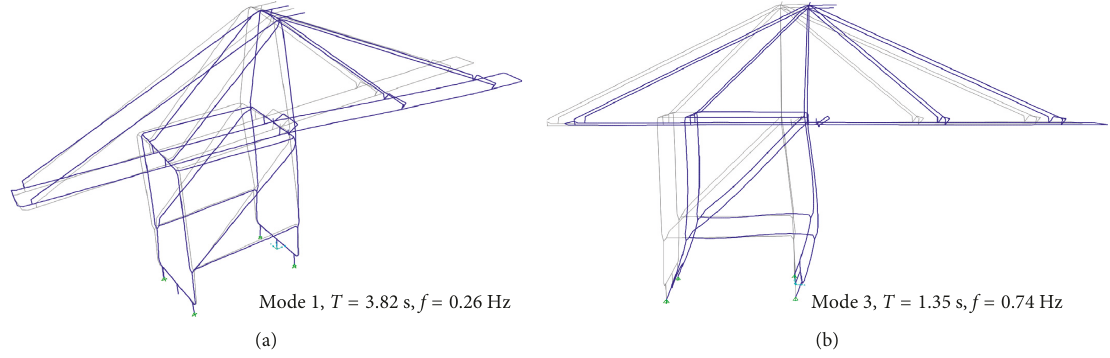
Figure 5: Numerical fundamental periods and modal shapes: (a) boom torsion and (b) portal sway. Table 2: Soil investigation at a seaport in South Korea. Boreholes Shear wave velocity GL. − 30m, v (m/s) Soil types s